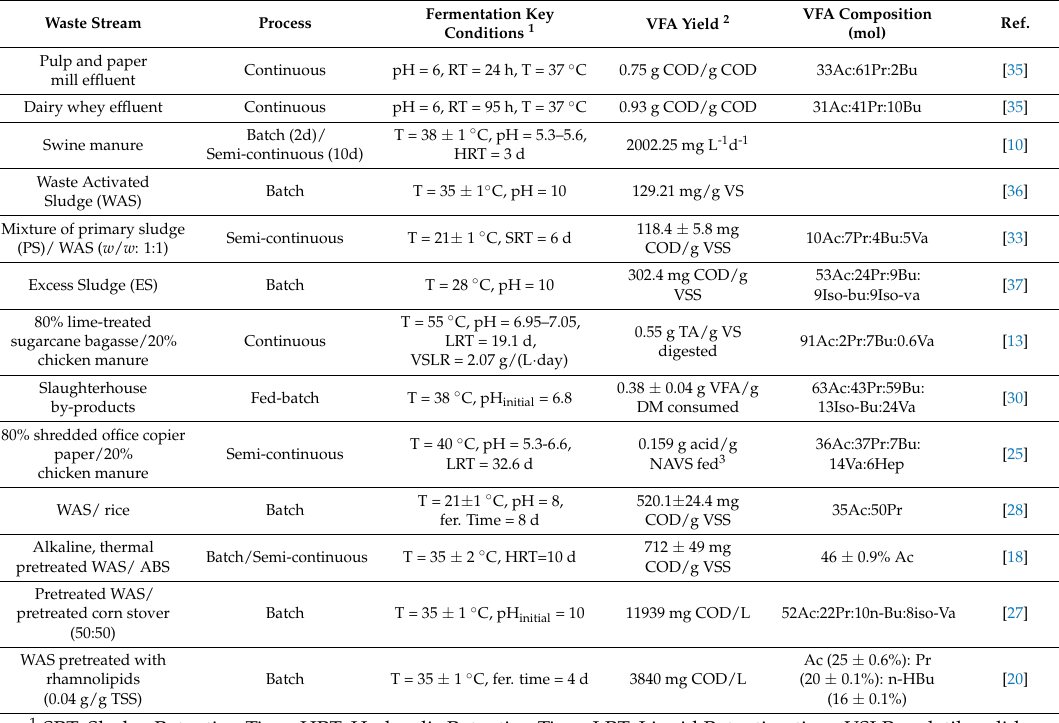
Table 1. Different waste streams used for Volatile Fatty Acids (VFA)